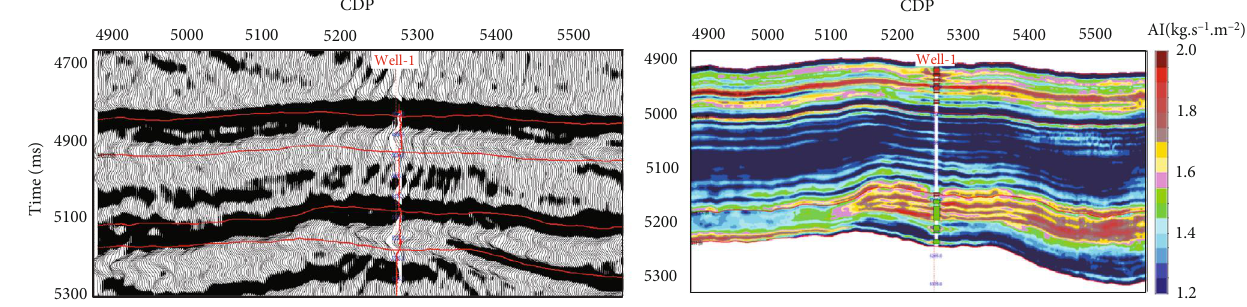
Figure 10: Poststack acoustic impedance inversion pro fi le of well